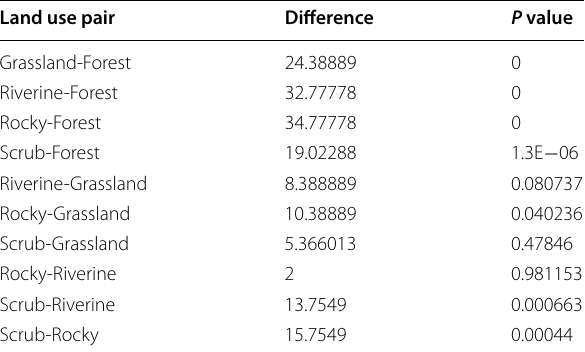
Table 1 Multiple pair-wise bird richness comparisons between the studied land use types